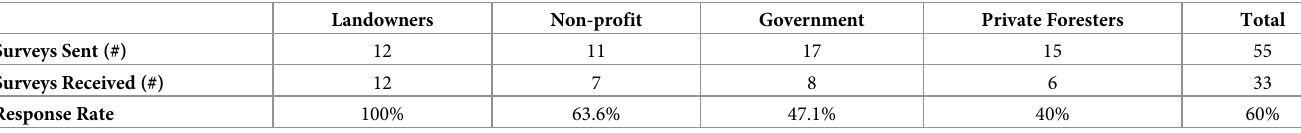
Table 3. Response rate for the first SWOT survey by selected stakeholder